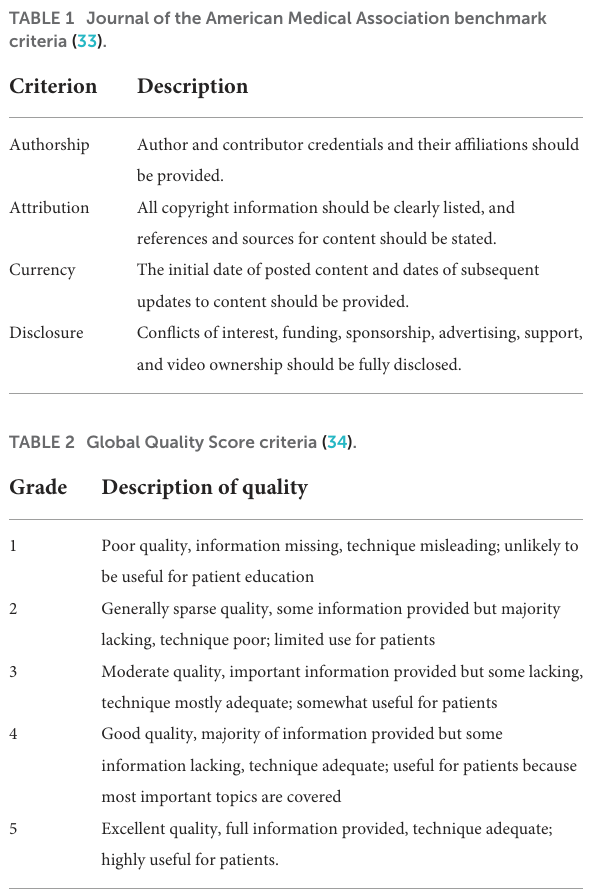
TABLE 1 Journal of the American Medical Association benchmark criteria (33).